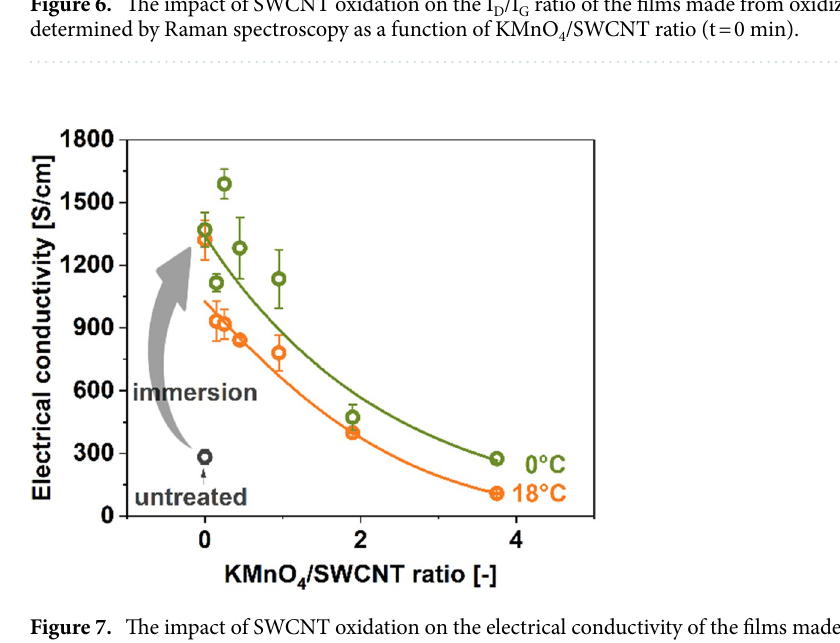
Figure 7. The impact of SWCNT oxidation on the electrical conductivity of the films made from oxidized SWCNTs as a function of KMnO 4 /SWCNT ratio (t = 0